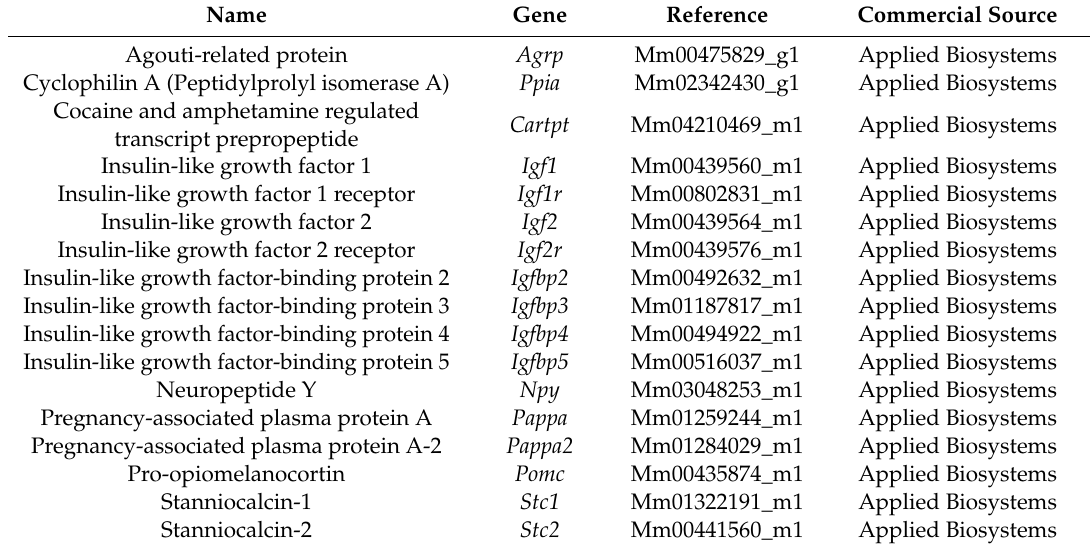
Table 5. List of TaqMan probes used for